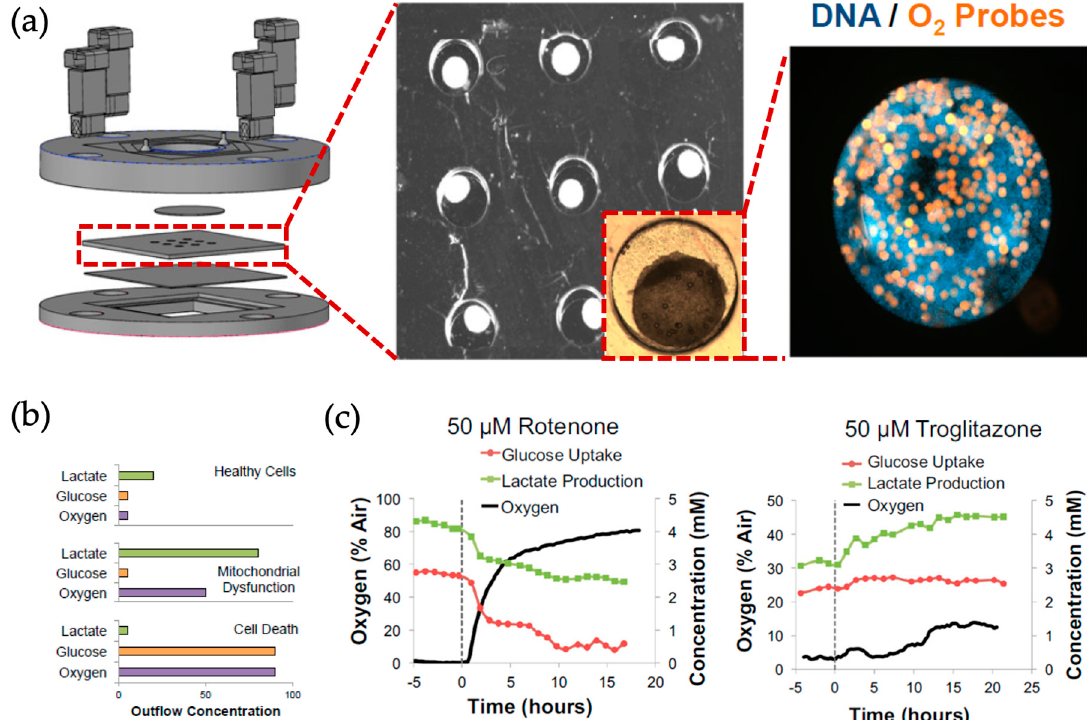
Figure 1. ( a ) Liver-on-a-chip for multiplexed culture of nine HepG2/C3A liver organoids